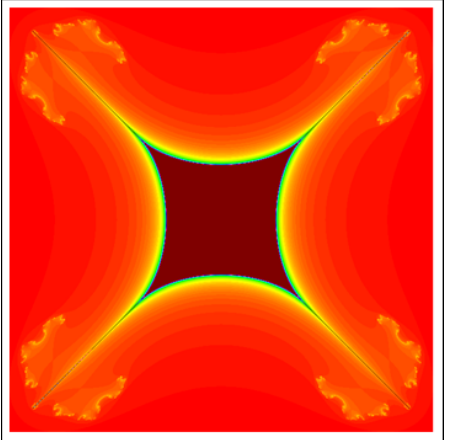
Figure 54. Multi-corn via F-iteration with image visual time = 50.1 s.